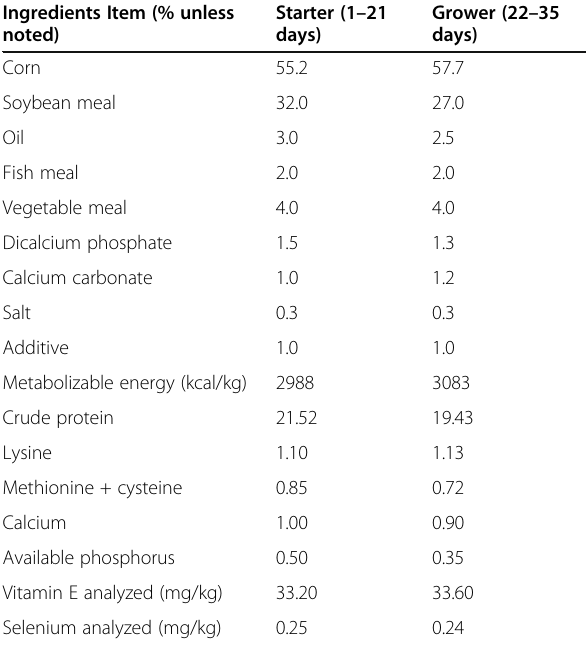
Table 1 Ingredient and nutrient composition of basal